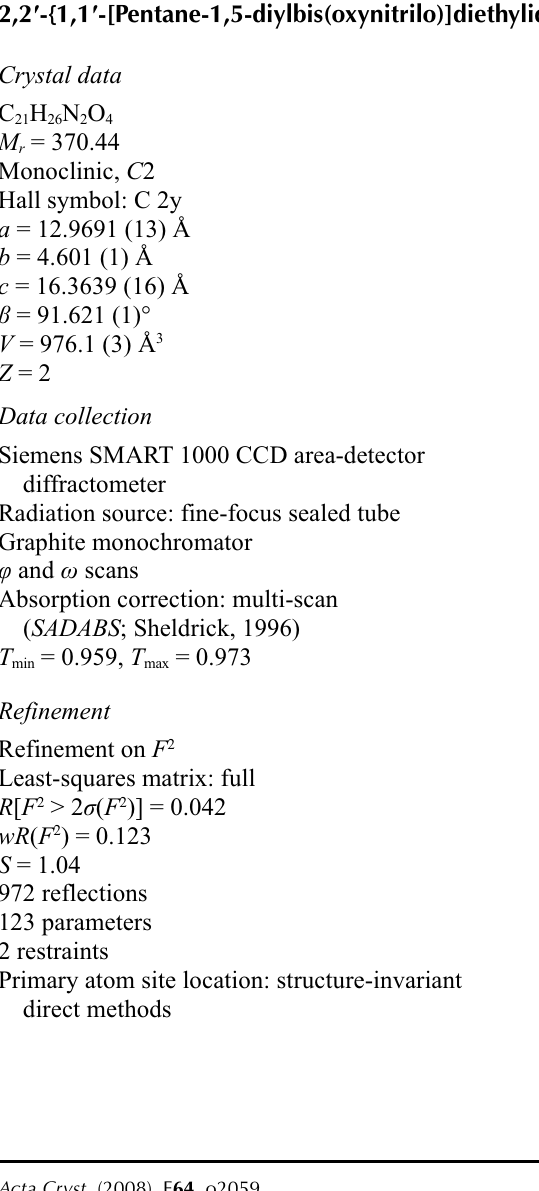
The molecular structure of the title compound with atom numbering scheme [Symmetry codes: A: - x , y , - z + 1]. Displacement ellipsoids for non-hydrogen atoms are drawn at the 30% probability